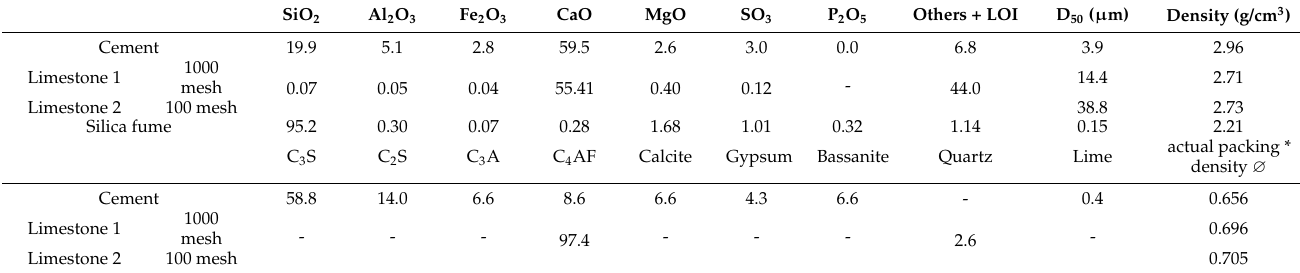
Table 1. Chemical composition (wt %) and other properties of experimental materials.